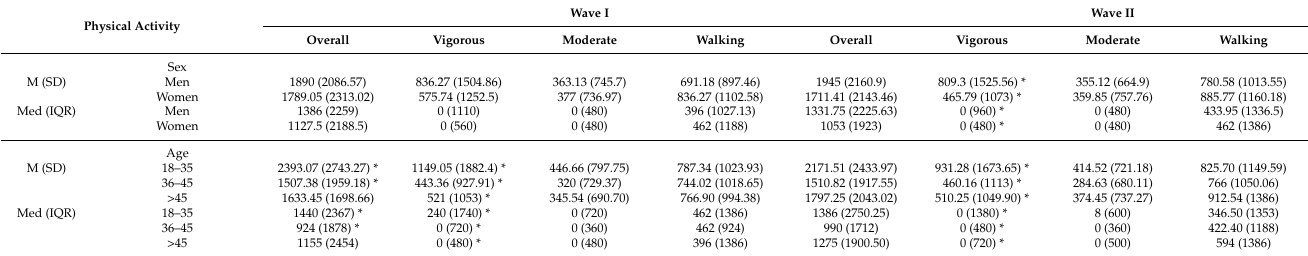
Table 3. Comparison of physical activity (MET minutes/week) by variables of interest in Wave I and Wave II. WaveI PhysicalActivity